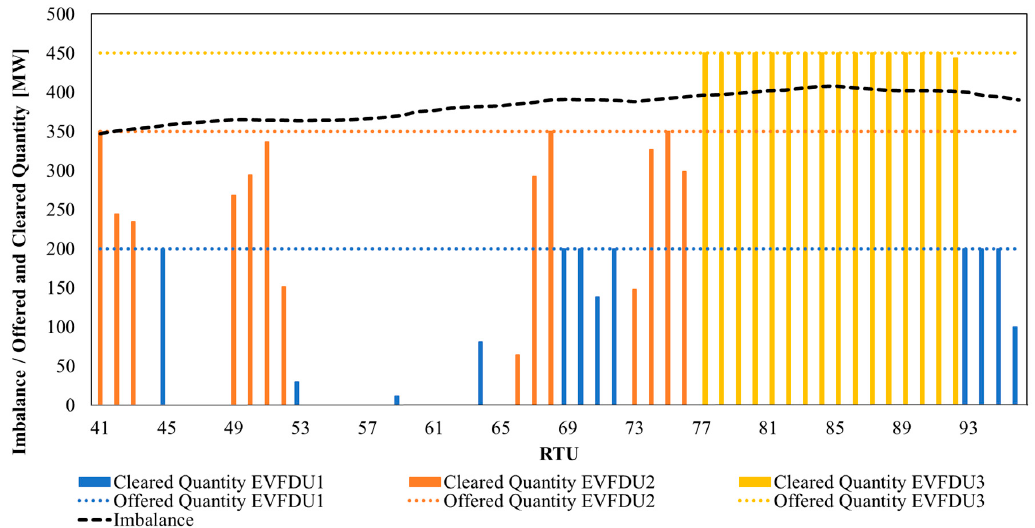
Figure 21. Example of clearing of an exclusive in volume fully divisible order.